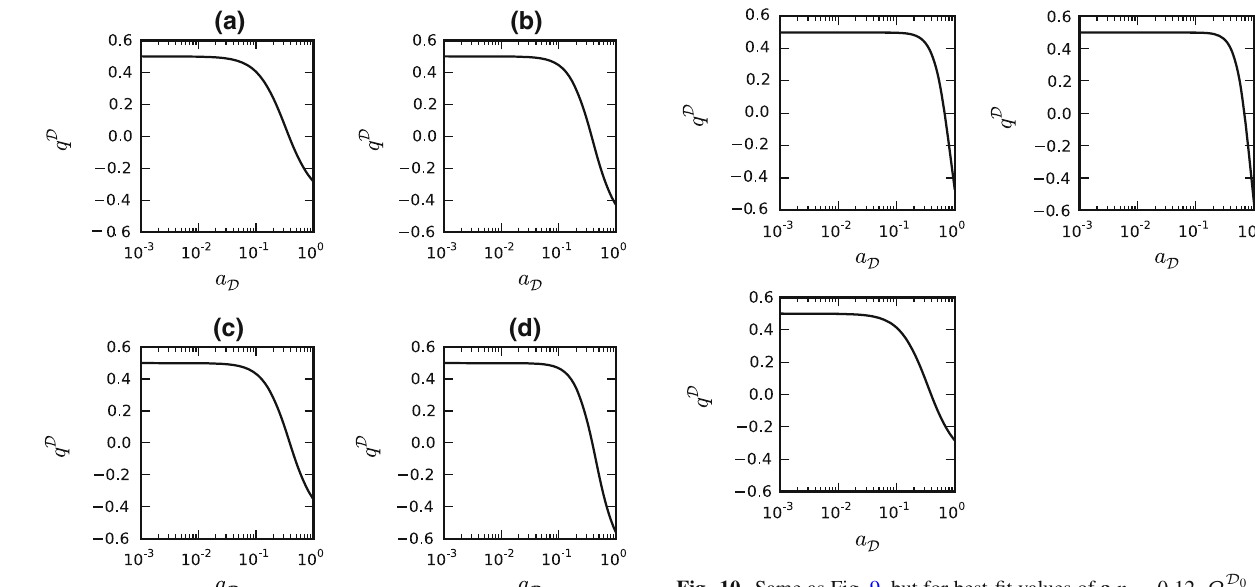
Fig. 10 Same as Fig. 9, but for best-fit values of a n = 0 . 12, Ω D 0 m = 0 . 38, b n = 0 . 5, Ω D 0 m = 0 . 397, and c n = − 1 . 1, Ω D 0 m = 0 .